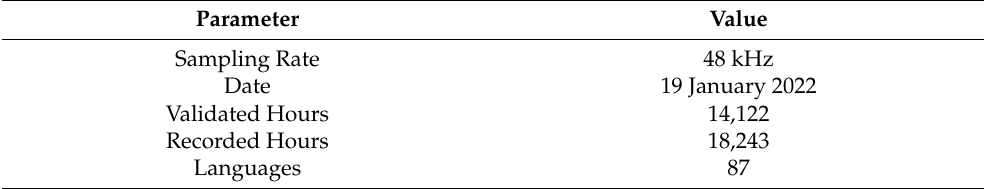
Table 2. Mozilla corpus